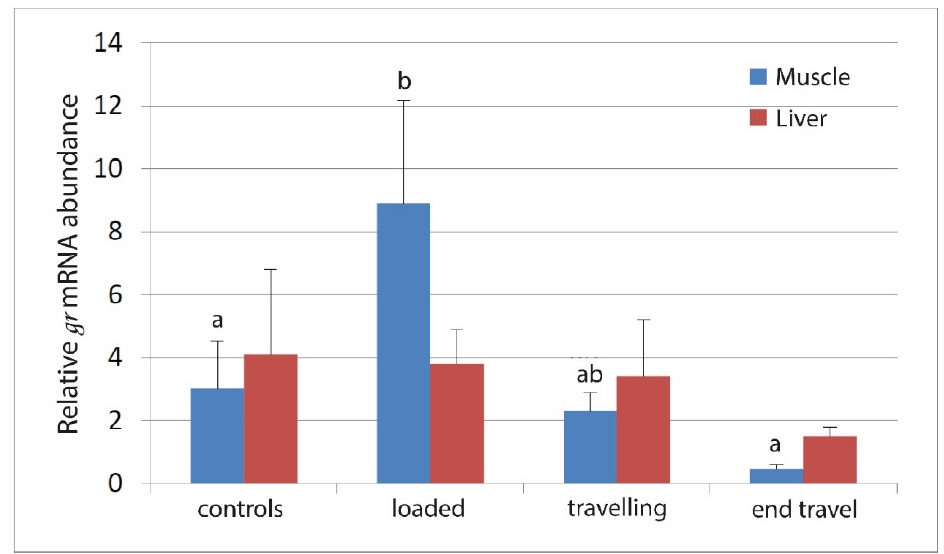
Figure 2. Relative expression of glucocorticoid receptor mRNA detected in meagre muscle and liver. Real-Time PCR levels were calculated at four steps: at the fish farm, before transport; just loaded on the truck; during transport; at the end of transportation. Values are means ± standard error (SE) ( n = 10). a, b: Different letters denote statistically significant differences at the different sampling points, while the absence of letters indicates absence of significant differences.